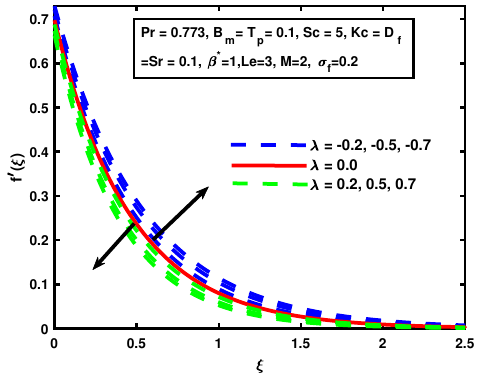
Figure 2. The impact of f (cid:48) ( ξ ) on suction/injection λ .